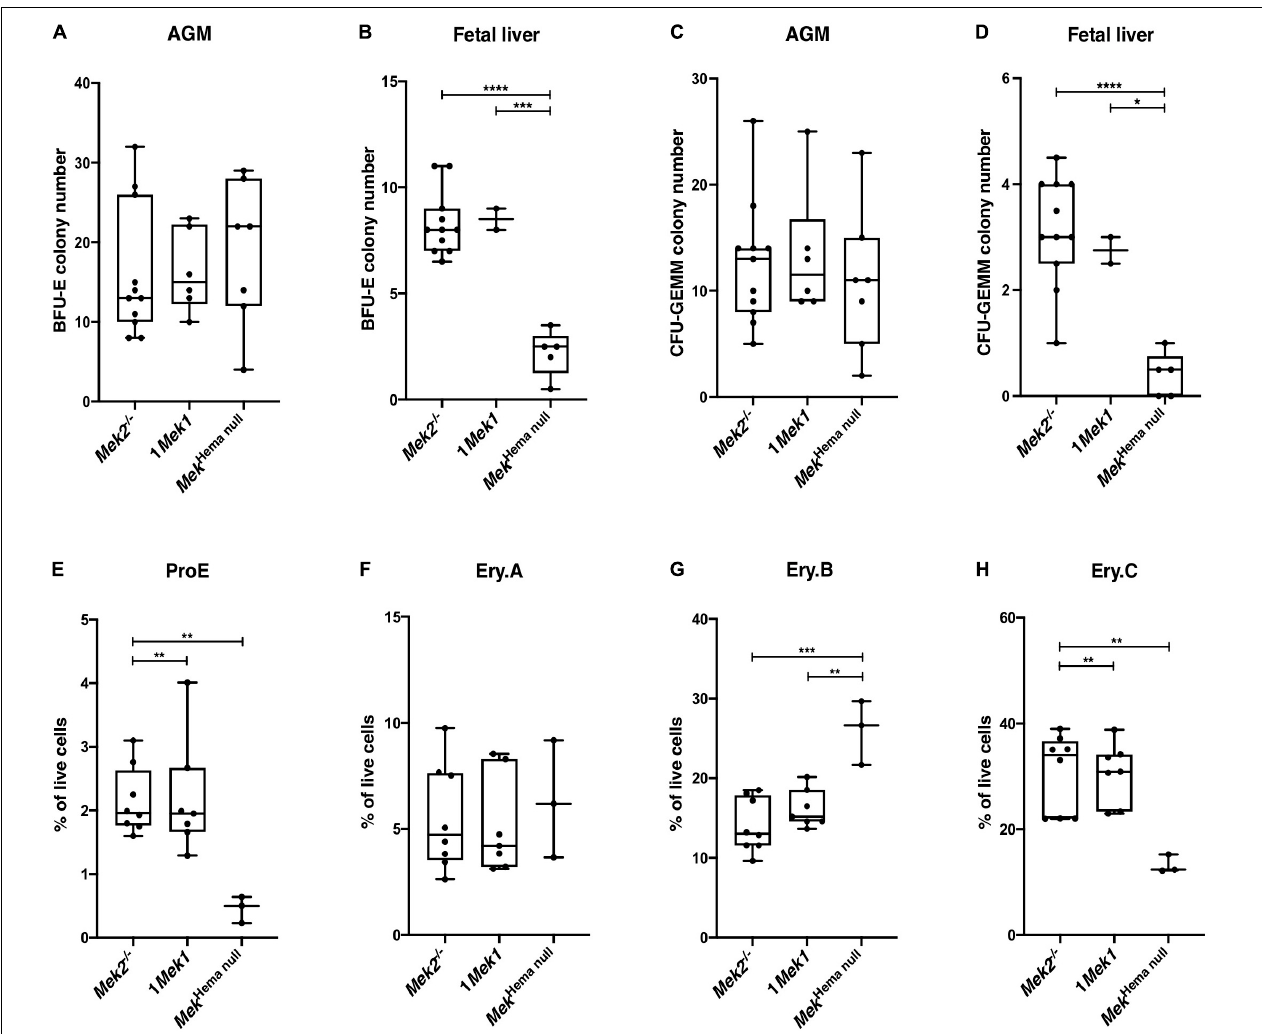
FIGURE 2 | Erythroid progenitors and subsets in Mek hema null mutants. (A–F) Numbers of BFU-E (A–C) and CFU-GEMM (D–F) colonies obtained after in vitro growth of E10.5 AGM region (A,C) and E14.5 fetal liver cells (B,D) from controls and Mek hema null embryos are presented. (E–H) Erythroid subset analysis by flow cytometry analysis in newborn spleen. Frequency of Ter119 med CD71 high FSC high (ProE; E ), Ter119 high CD71 high FSC high (Ery.A; F ), Ter119 high CD71 high FSC low (Ery.B; G ), and Ter119 high CD71 low FSC low (Ery.C; H ) are presented. They revealed a decrease of the ProE and Ery.B populations and an increase of the Ery.C population in Mek hema null samples. The results are presented as whiskers-and-boxes graph, and each dot represents an individual mouse. ANOVA with